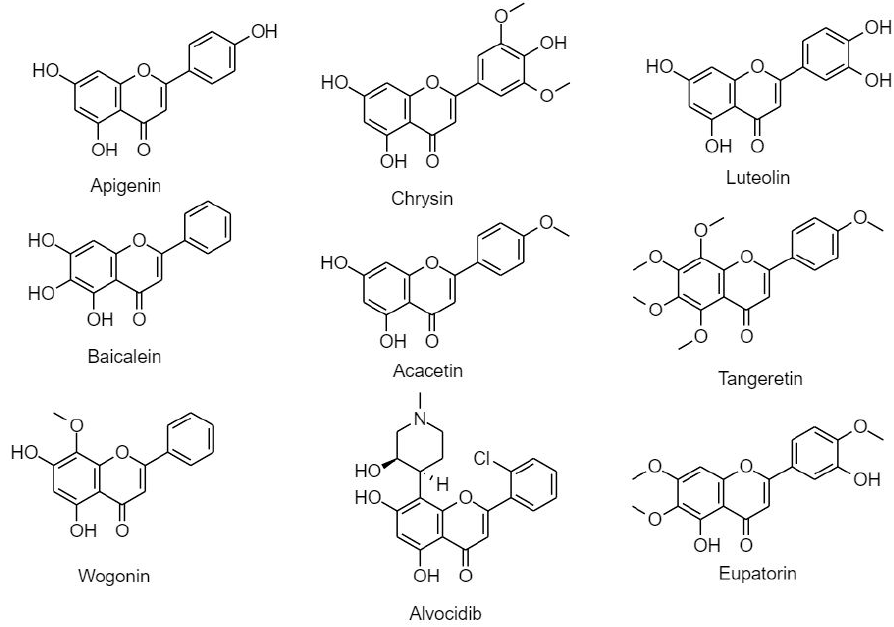
Figure 9. Classification and structure of flavones.